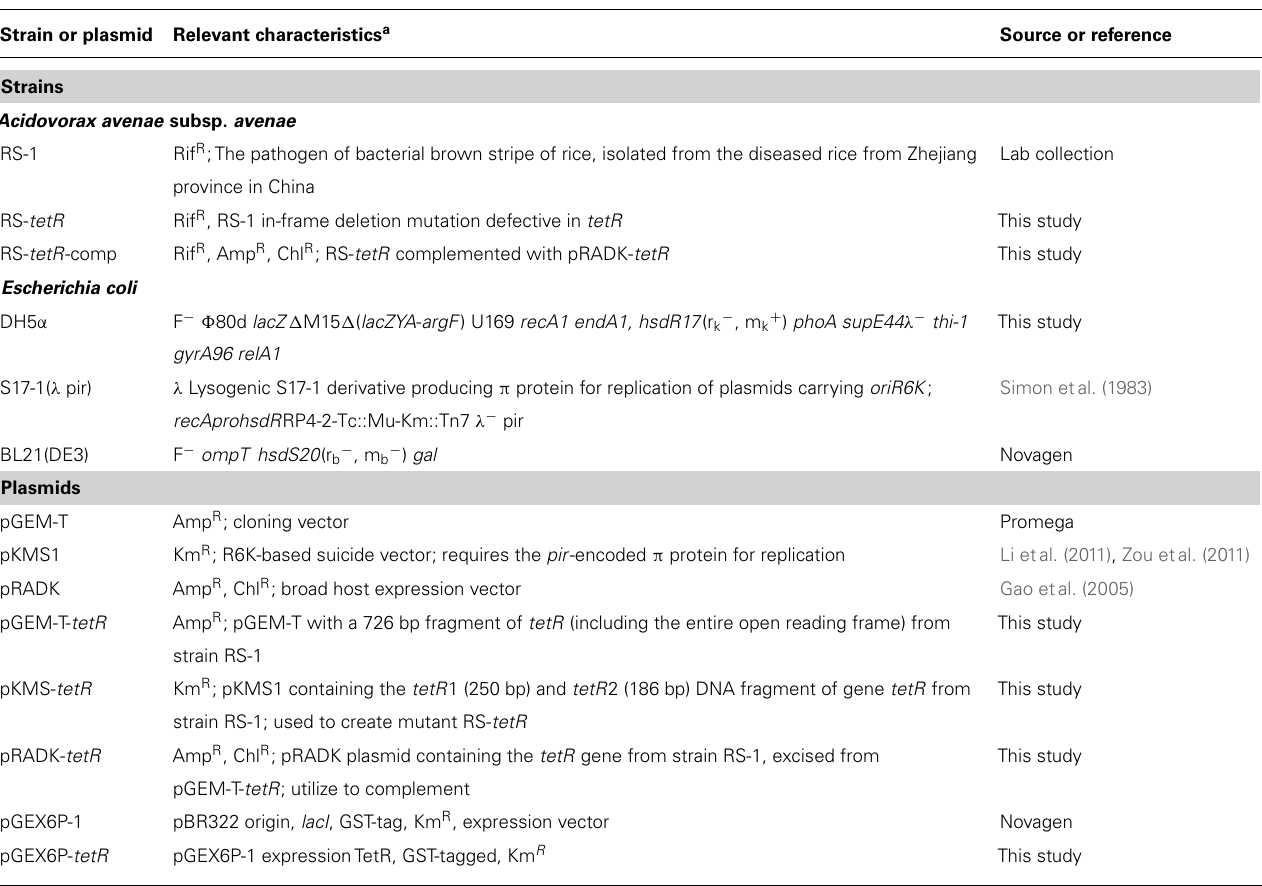
Table 1 | Strains and plasmids used in this